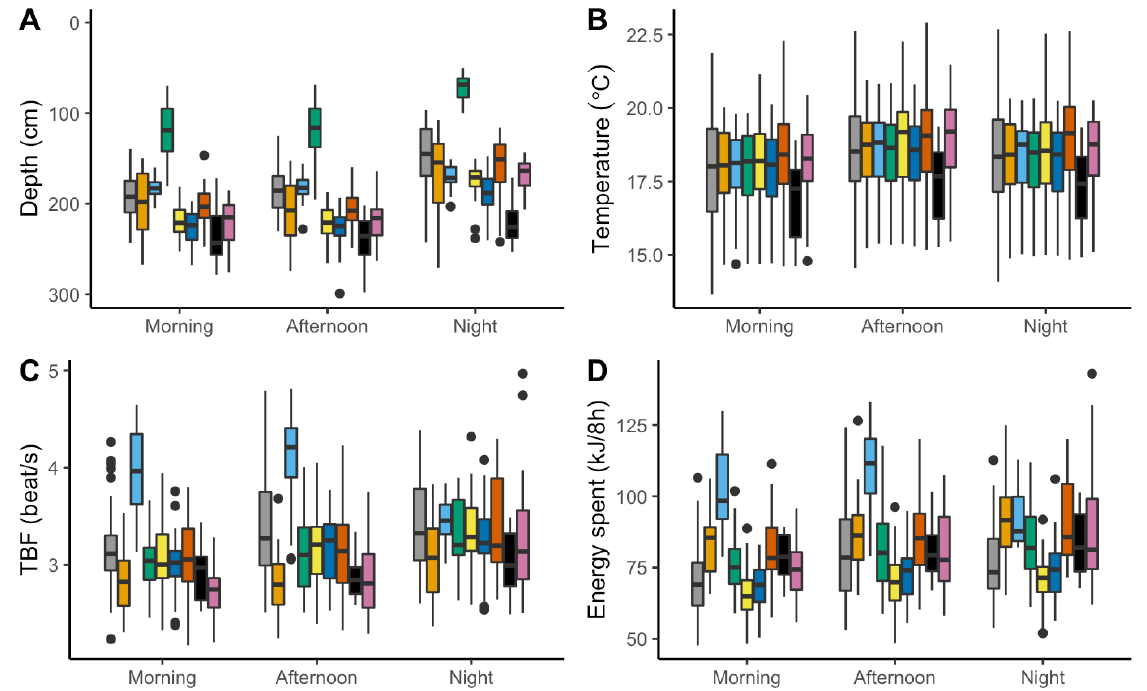
Figure 5. Depth (A), temperature (B), tail beat frequency (C) and estimated energy spent (D) by nine female allis shad during the morning (6AM:2PM), afternoon (2PM:10PM) and night (10PM:6AM) of their spawning season. Box plots show the distribution of the variables averaged (A, B, C) or cumulated (D) across 8-hour periods for each individual (colours as in Fig. 3, black for the individual whose tag stopped recording before the end of the experiment). In C, energy spent was computed from temperature and TBF using equations (1) and